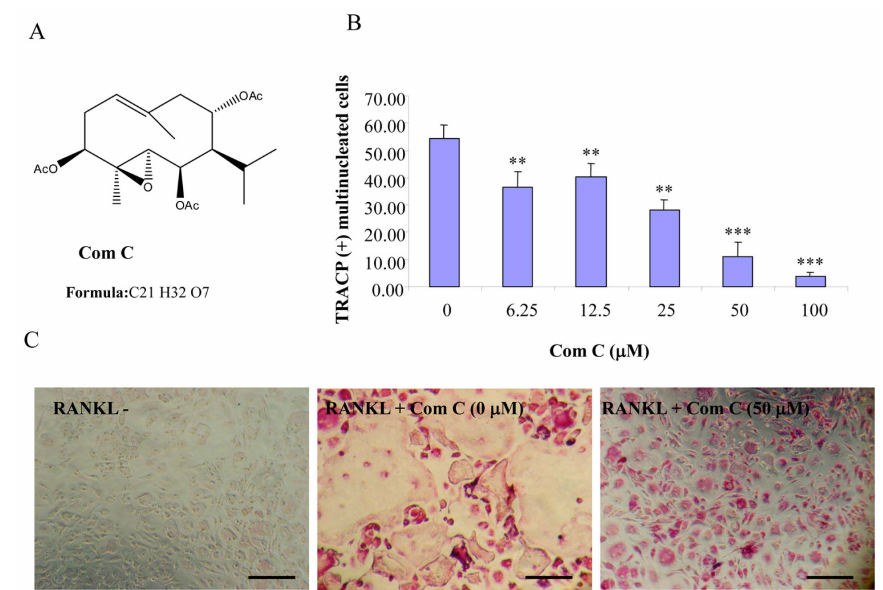
Figure 3. Compound C inhibits RANKL-induced osteoclastogenesis. ( A ) Chemical structure of compound C; ( B ) mouse BMMs cultured in a 96-well plate in the presence of RANKL (100 ng/mL) and M-CSF (10 ng/mL) with or without compound C for five days were fixed with 4% paraformaldehyde and stained for TRACP activity. Quantitative analysis shows the mean number of TRACP-positive multinucleated cells (MNC). (** p < 0.01 *** p < 0.001 compared to RANKL treated control, n = 3); and ( C ) representative light microscope images showing the effect of compound C on RANKL-induced osteoclast formation. (Mag = 20 ˆ , scale bar = 100 µ